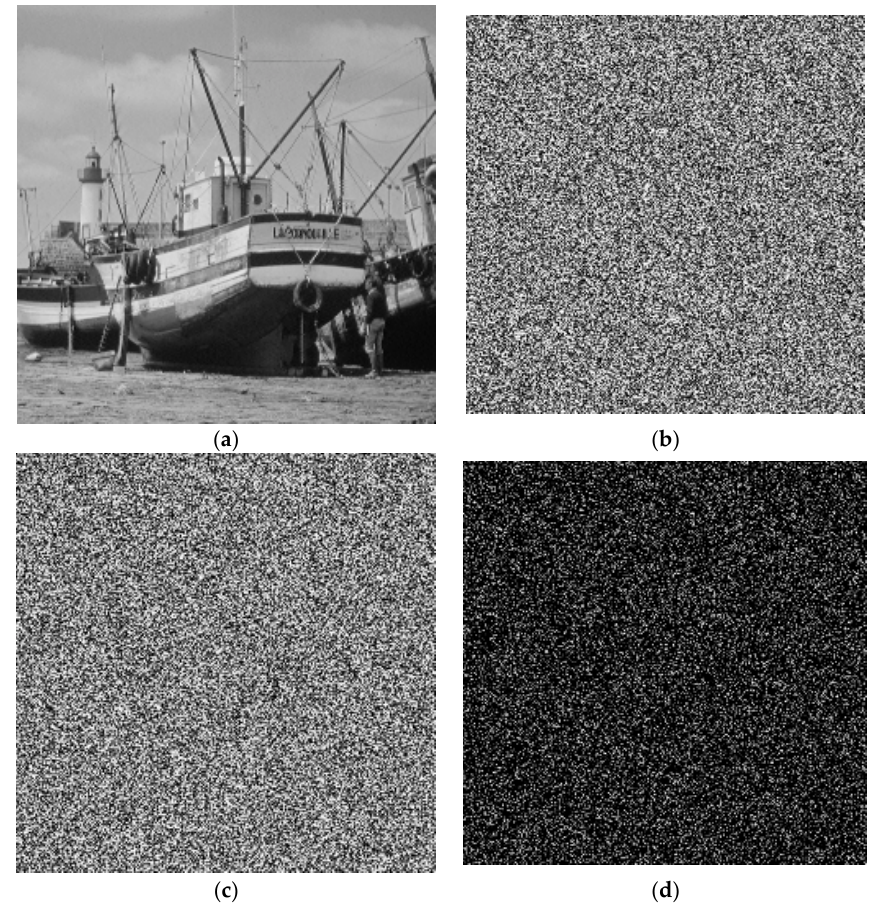
Figure 4. Key sensitivity for Boat. ( a ) Plain-image of Boat; ( b ) Encrypted image by key: 123456789012345; ( c ) Encrypted image by key: 123456789012346; ( d ) Difference image.